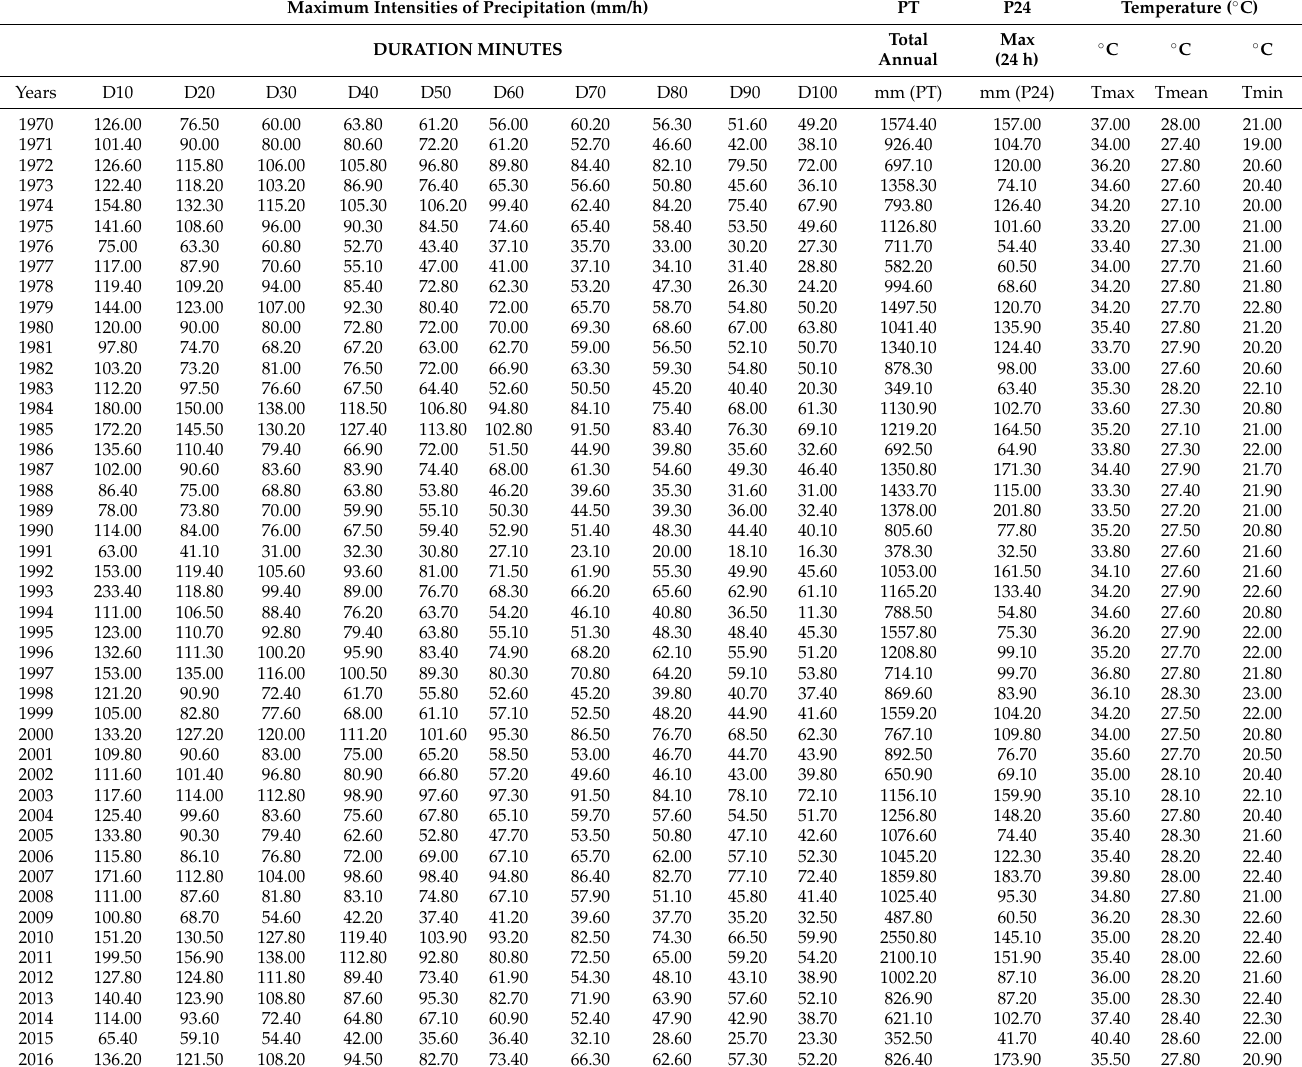
Table A3. Time series of maximum intensities for a given duration of rain of ten minutes (D10),